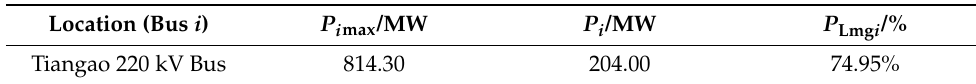
Table 4. The minimum local load margin in Qujing Power Grid.